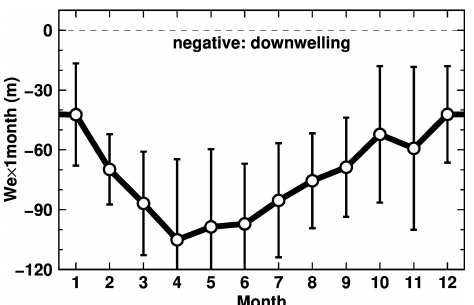
Figure 13. Seasonal variations in monthly Ekman downwelling (a product of Ekman velocity and a month (30d)). The monthly value is climatology averaged over the period